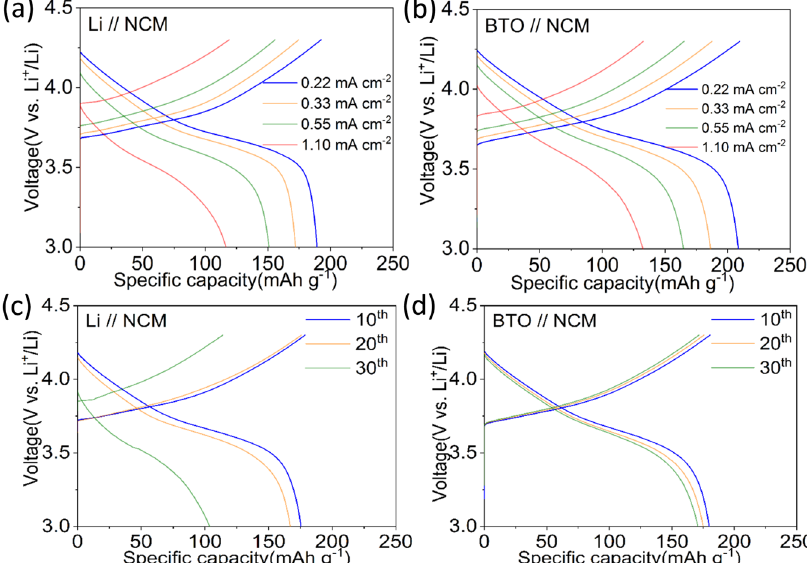
Fig. 6 Voltage pro fi les of Li metal and BTO scaffold when paired with NCM positive electrode. a , b Rate test from 0.22 mA cm − 2 to 1.10 mA cm − 2 . c , d Voltage pro fi les when cycled at 0.33 mA cm − 2 at different cycle